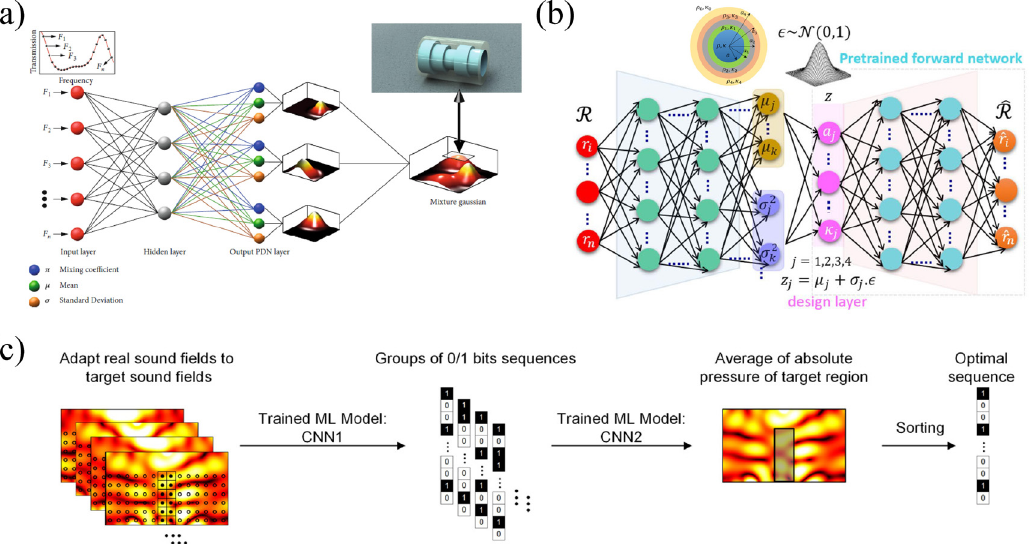
Figure 5: Probabilistic machine learning inverse design scheme. (a)FuzzydesignforacousticstructurescombiningdeeplearningandGaussianmixturesampling[102].(b)Designofcore – shellacousticcloak based on probabilistic TNN architecture [103]. (c) Machine learning for controlling regional sound fi eld